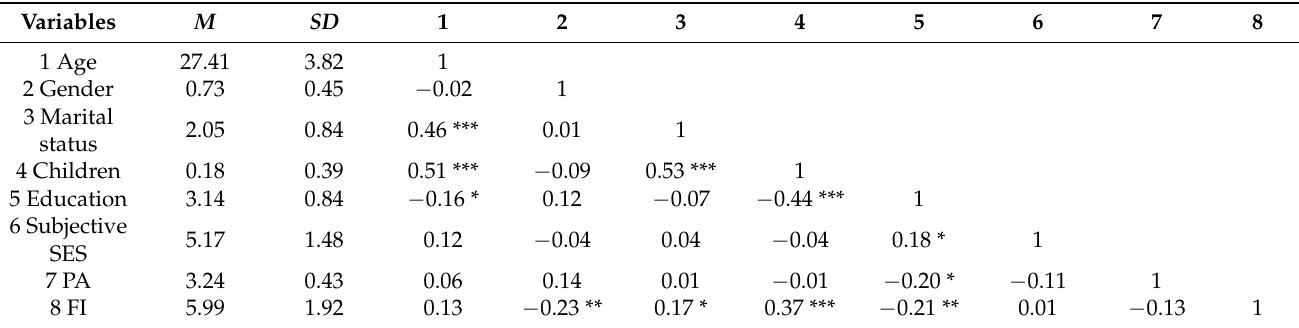
Table 1. Descriptive statistics and bivariate correlations of the key variables.